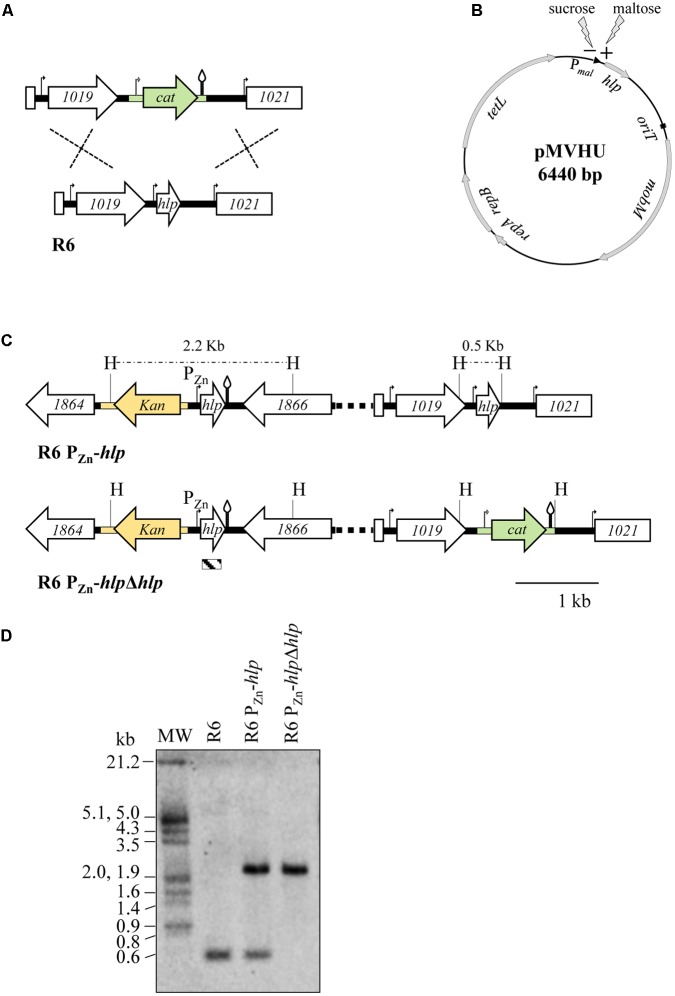
Strategies to knockout the hlp gene in S. pneumoniae.
(A) Schematic showing the replacement of the chromosomal hlp gene with the chloramphenicol resistance cassette (green drawing). R6 genes (spr numbering) are indicated by white arrows. Promoters are shown as curved arrows and transcription terminators as stem and loop structures. (B) Representation of plasmid pMVHU containing the hlp gene under the control of the maltose promoter. (C) Schematic showing the in cis duplication of the hlp gene in strain R6 PZn-hlp, by placing an additional copy of the gene under the control of a Zn-inducible promoter. The kanamycin resistance cassette is presented in yellow. The organization of strain R6 PZn-hlpΔhlp is also represented. The chloramphenicol resistance cassette, promoters, and transcription terminators are represented as in (A), H, HindIII targets and predicted sizes of fragments. Distances between HindIII targets are shown above the dashed lines. The striped box at the bottom of the figure represents the hlp probe used for Southern analysis and its position inside the hlp gene. (D) Southern blot analysis of the R6, R6 PZn-hlp, and R6 PZn-hlpΔhlp strains. Chromosomal DNA from the strains was cut with HindIII, separated by agarose gel electrophoresis, transferred to a nylon membrane and hybridized with the biotinylated hlp probe shown in (C).